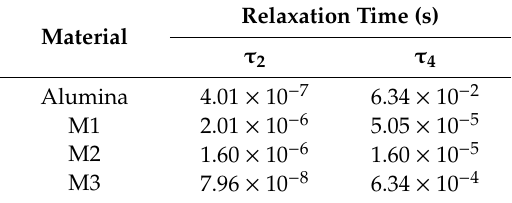
Table 3. Relaxation times at the maximum points of the semicircles for high and medium frequencies.